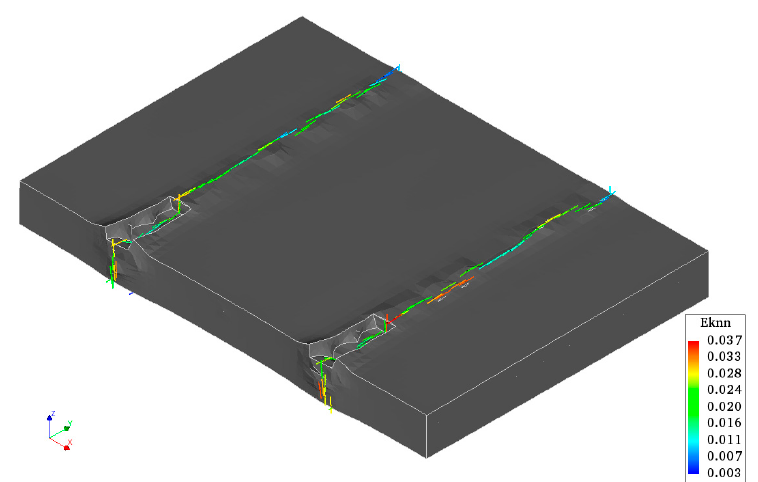
Figure 12. The predicted transverse crack pattern of CRCP.